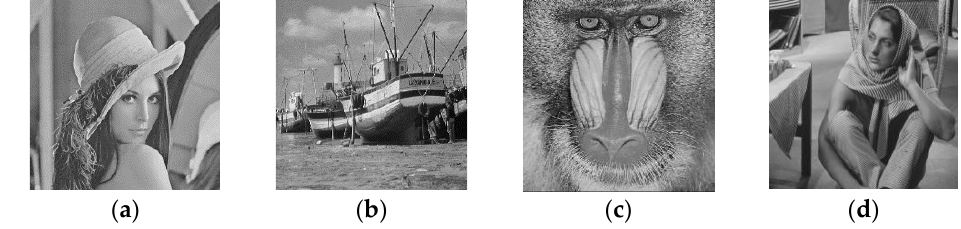
Figure 6. Shows some of the standard images: ( a ) Lena, ( b ) Boat, ( c ) Baboon and ( d ) Barbara.